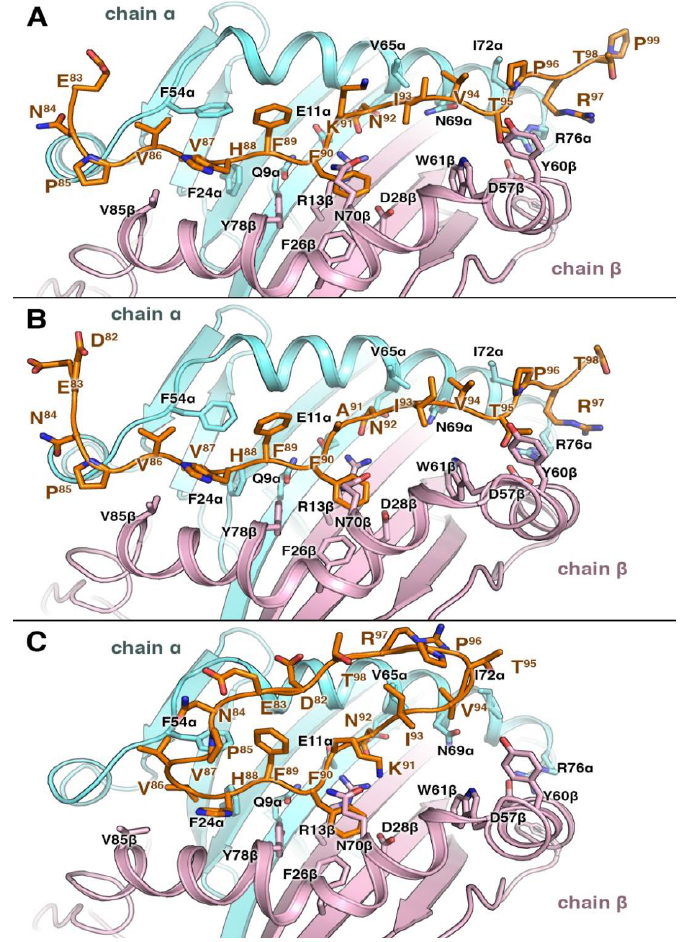
Figure 5. Binding of MBP 83 – 99 , linear MBP 82 – 98 (A 91 ), and cyclic MBP 82 – 98 to HLA-DR2b (panels ( A ), ( B ), and ( C ), respectively). Peptides are shown in orange cartoon representation and sticks (side chains), while chains α and β are depicted in cyan and pink cartoon , respectively.